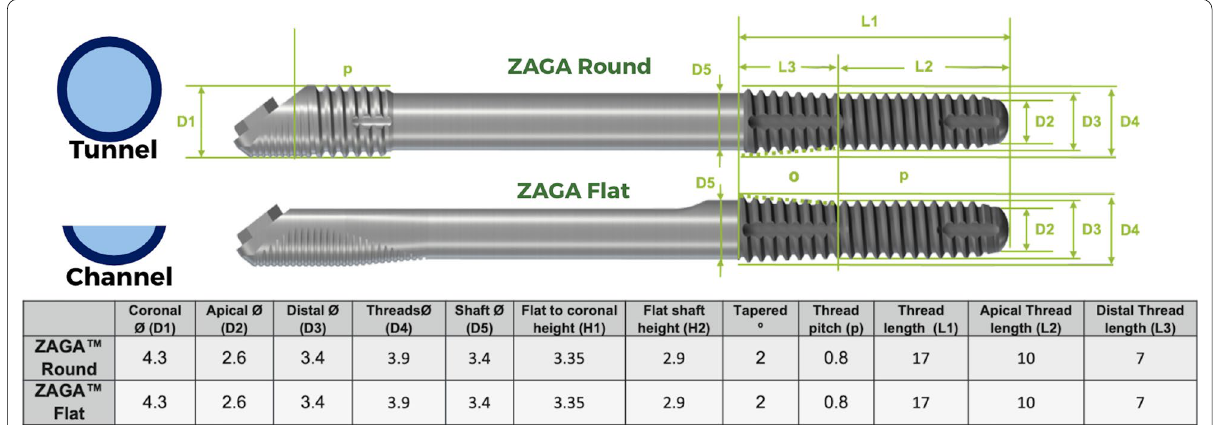
Fig. 2 Technical characteristics, similarities, and differences between the two types of zygomatic implants are graphically shown. Straumann ZAGA‑Flat has a circular segment section, whereas Straumann ZAGA‑Round has a circular one. Both zygomatic implants share unique features of having a tapered design and narrow